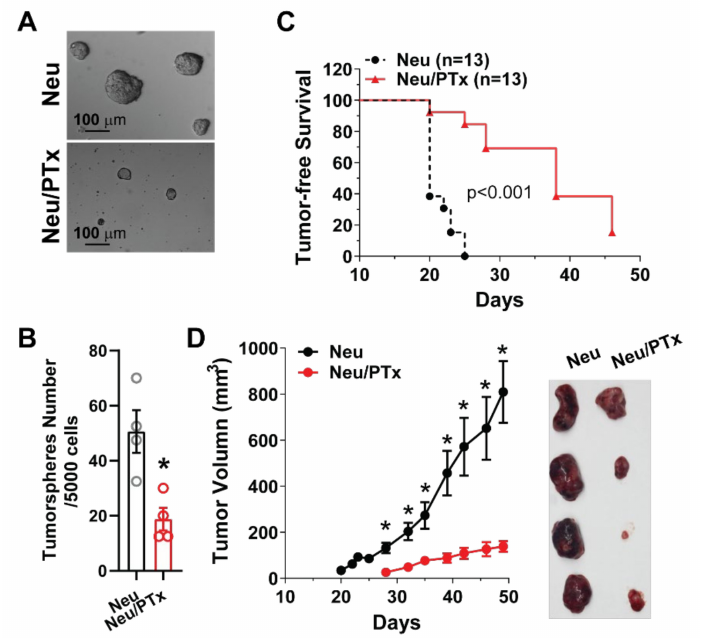
Figure 3. Gi/o-GPCR signaling regulates CSC tumorigenecity in established breast tumors. Total 5000 cells were plated per well. Cells were plated on 6-well plates for tumorsphere-forming assays. Representative images of tumorspheres are shown in ( A ), and quantitative data of tumorsphere number are shown in ( B ). * p < 0.05 vs. Neu, n = 4. ( C , D ) 1 × 10 5 cells were implanted into the mammary gland of nude mice, and tumor growth was measured via caliper. Tumor-free survival curves are shown in ( C ), and tumor growth curves are shown in ( D ). Representative images of tumors are shown in the right panel of ( D ). * p < 0.05 vs. Neu/PTx, n =